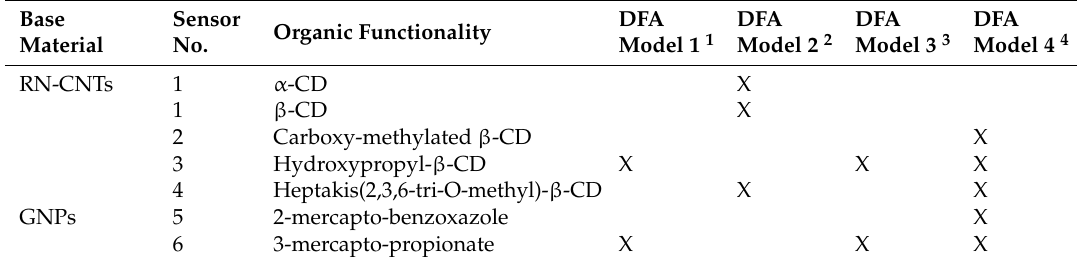
Table 3. Base materials and organic functionalities of the nanomaterial-based sensors. Used with permission from